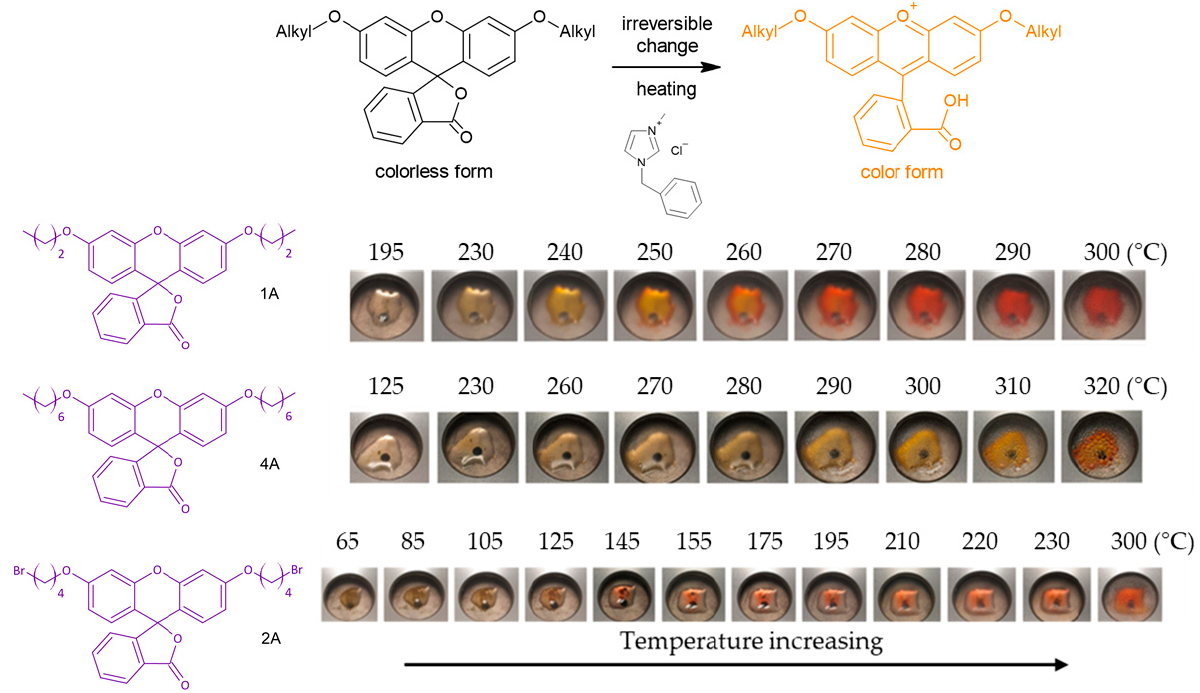
Figure 7. Scheme of thermochromic reaction of fluoran derivatives and IL (top) and changes of color during heating of fluoran derivative-IL mixtures.